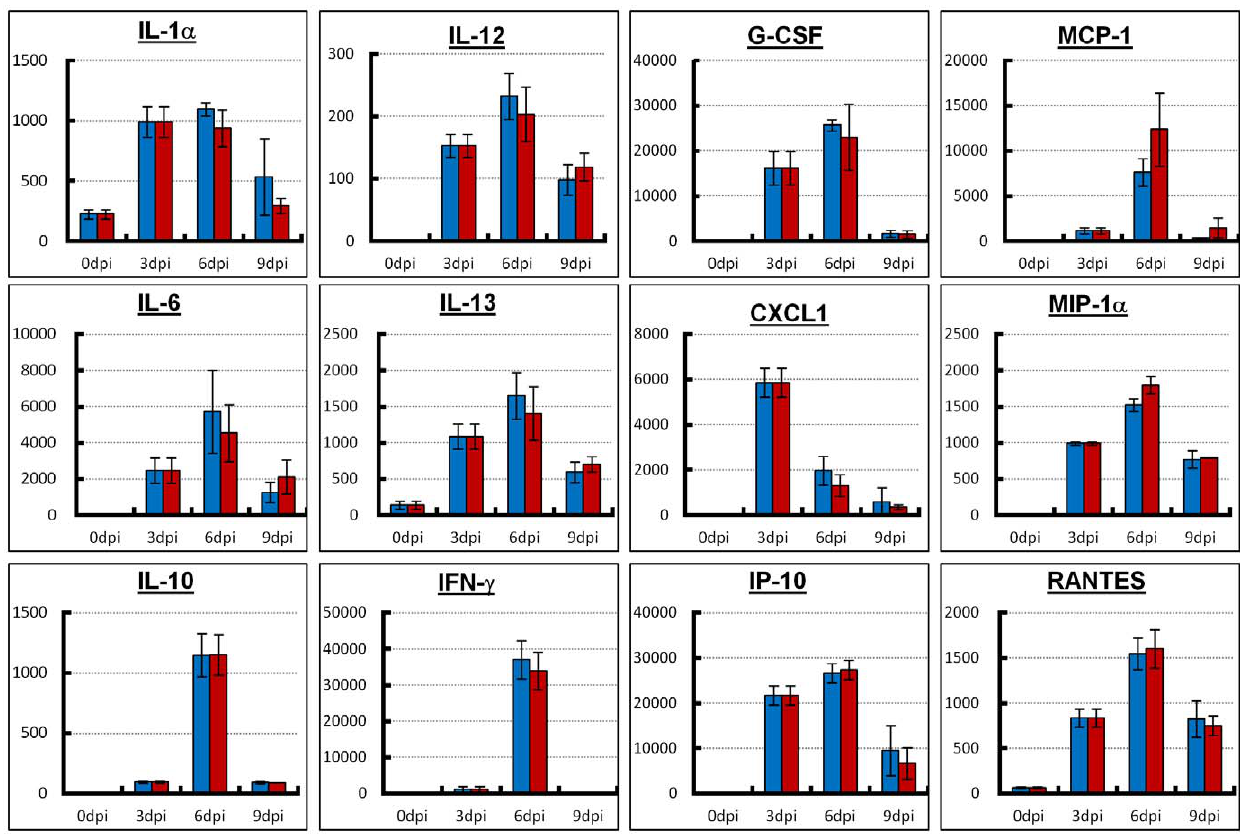
Figure 4. Cytokine and chemokine expression in lungs from infected mice with combination therapy or monotherapy. Mice intranasally inoculated with an extremely high dose (3741 MLD 50 ) of PR8 virus were treated with laninamivir octanoate. The mice were additionally administered artificial surfactant (combination therapy, red bars) or normal saline solution (monotherapy, blue bars) intranasally once daily during 3– 14 days postinfection. Three mice from each group were sacrificed at the indicated days postinfection and their lung homogenates were used to analyze the expression of 22 cytokines and chemokines using the MILLIPLEX MAP Panel. Only 12 cytokines and chemokines are shown; the remainder was under the limit of detection for the assay. The concentration in each panel is pg/ml. Differences in means 6 SD are shown.